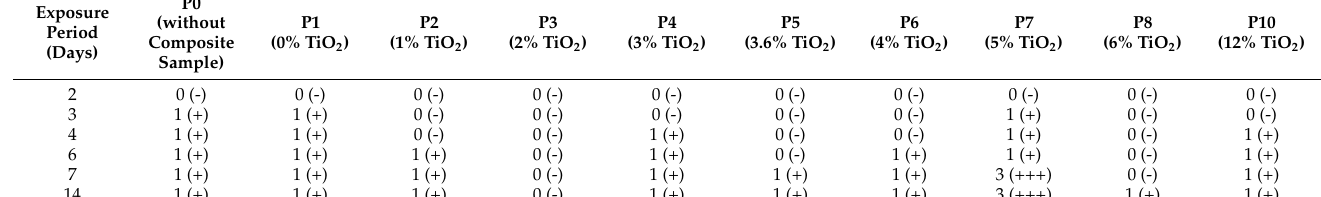
Figure 4. Microscopic examination of the behavior of samples exposed to Pseudomonas Aeruginosa : ( a ) The presence of biological material on the surface of the composite specimen at the time of sowing (1:2 mm); ( b ) Identification of the inhibition halo zone (1:2 mm); ( c ) Growth of colonies (1:500 µ m); ( d ) Detail growth of colonies (1:500 µ m). Table 5. Quantification of the microbiological load of the system according to STAS 12718 for samples exposed to Staphylo- coccus Aureus .